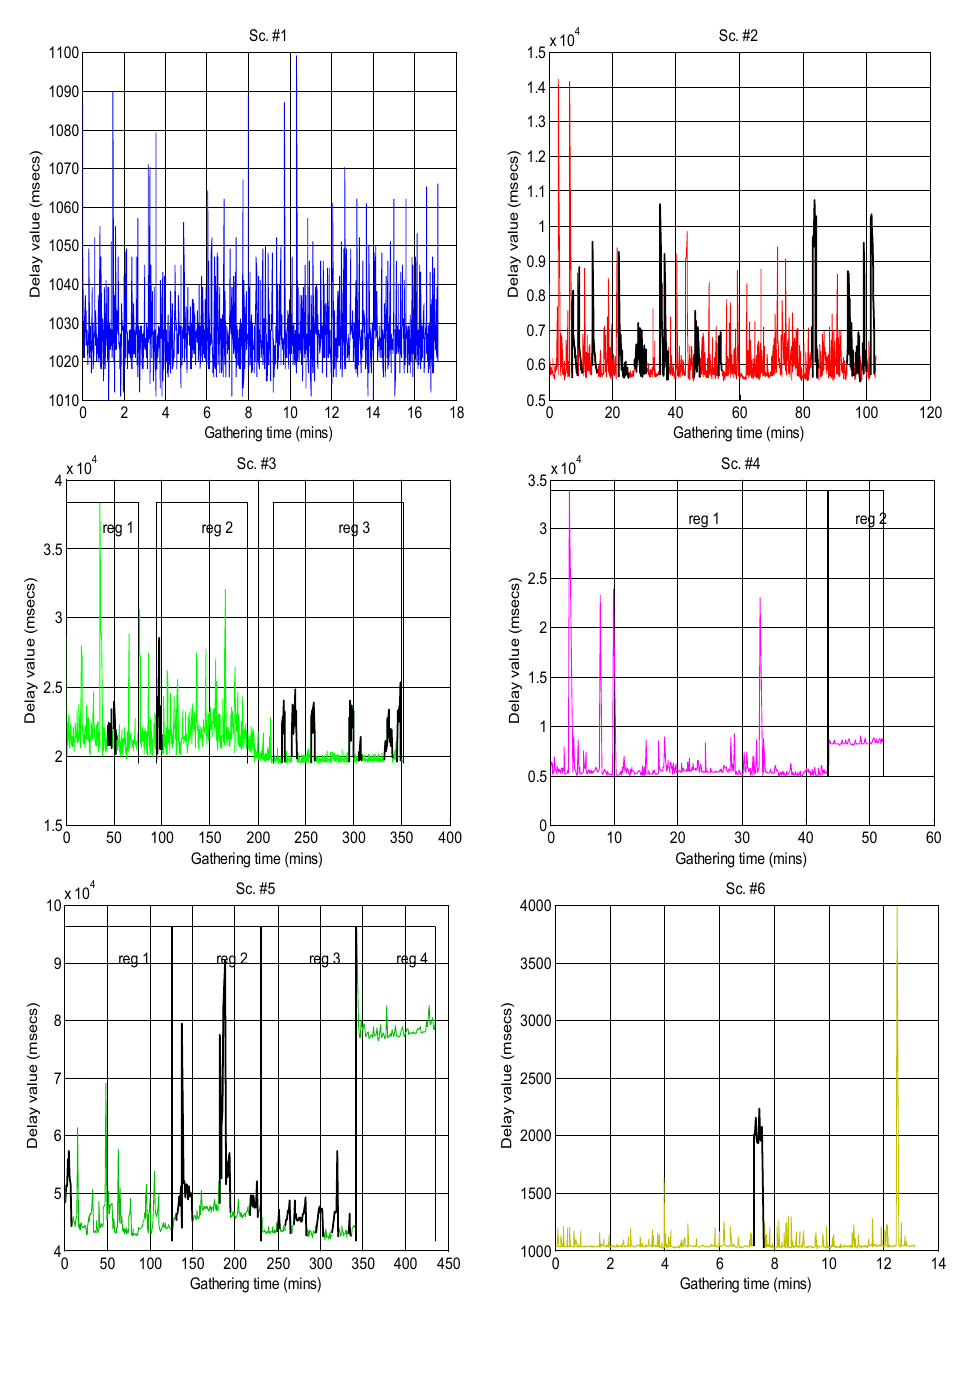
Figure 2. Real delays, in milliseconds, gathered from the sensory loop of the scenarios of Table 1. They present bursts and regime changes (visually detected with black lines), and in some cases smooth trend variations. The bottom x-axes show the absolute time when each sample was gathered. Note the highly deterministic behavior of scenario